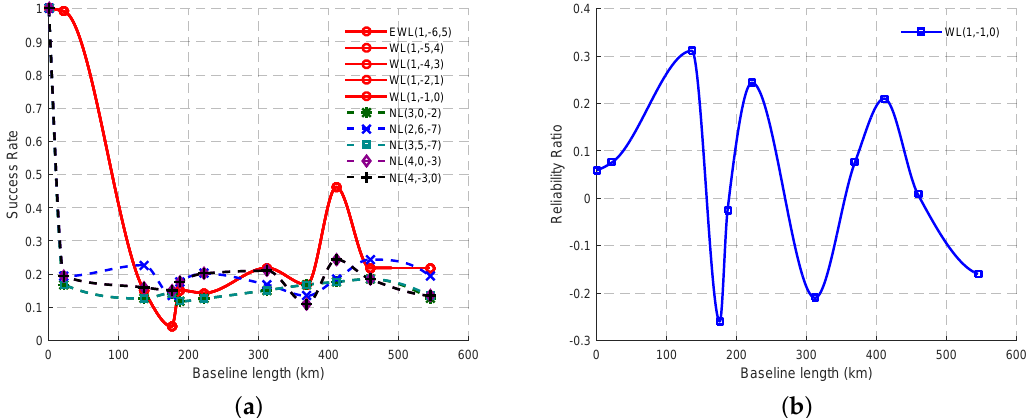
Figure 11. The variation trend of AR success rate in GB TCAR. ( a ) The success rates of all the selected combined signals; ( b ) The reliable ratio of WL(1, − 1, 0) compared to EWL(1, − 6,